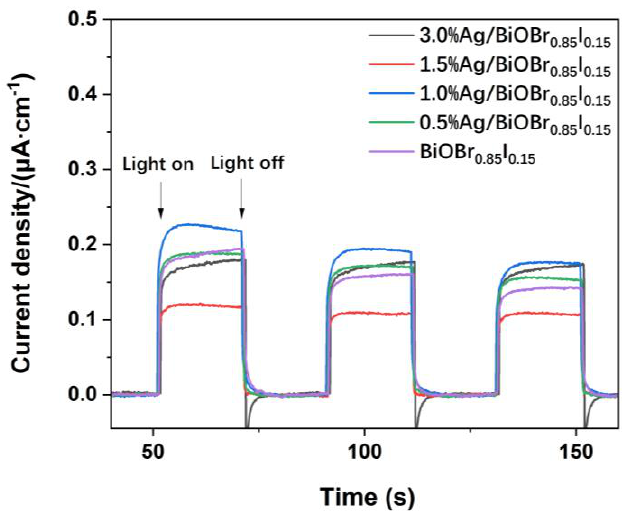
Figure 10. Transient photocurrent response for BiOBr 0.85 I 0.15 and Ag/BiOBr 0.85 I 0.15 photocatalysts.